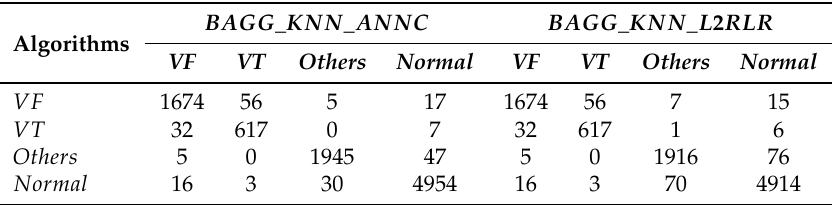
Confusion matrix for classification of VF , VT , Others , and Normal using the